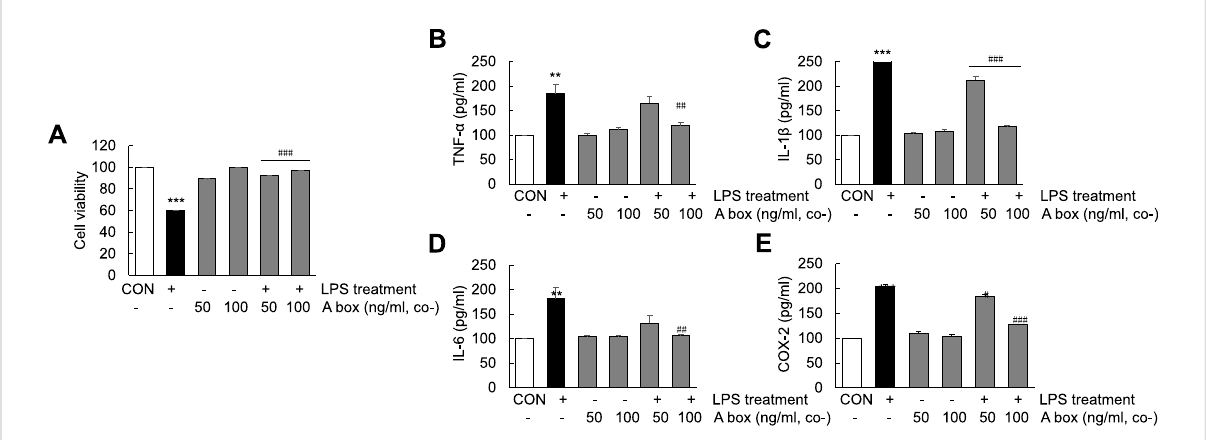
FIGURE 7 Suppression of cell apoptosis and decrease in proin fl ammatory cytokine levels in LPS-induced Huh7 cells following HMGB1-A box treatment. Huh7 cells were treated HMGB1-A box (50 and 100 ng/ml) only for 24 h without LPS treatment and LPS (1000 ng/ml) for 24 h with or without HMGB1-A box (50 and 100 ng/ml). MTT assay was performed to measure cell viability (A) . ELISA was performed to assess the expression of proin fl ammatorycytokines(TNF- α ,IL-1 β ,and IL-6)and COX-2 ( B – E) .*** p < 0.001 vs.control, # p < 0.05, ## p < 0.01, ### p < 0.001 vs.LPS